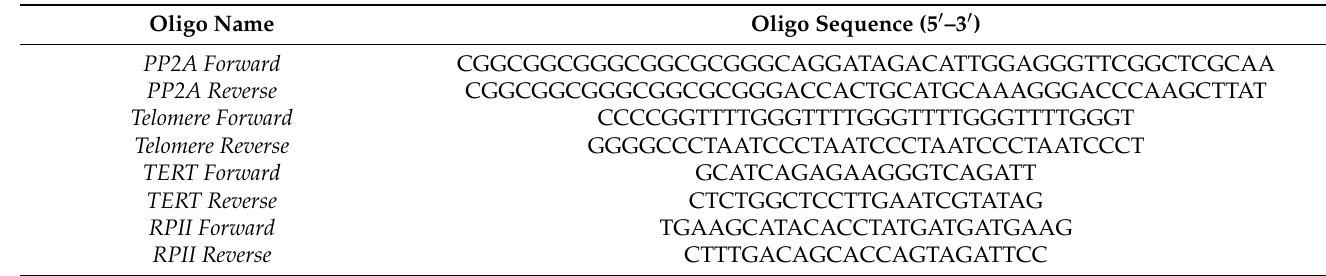
Table 2. Oligos used for all Monochrome Multiplex Quantitative PCR (MMQPCR) and quantitative reverse transcriptase PCR (qRT-PCR)